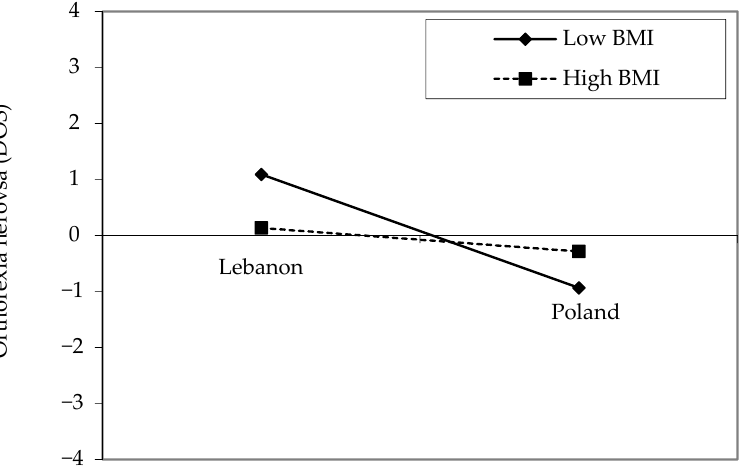
Figure 1. Plots of the two-way interaction effect between country and Body Mass Index. Note: In this figure, standardized values were used.